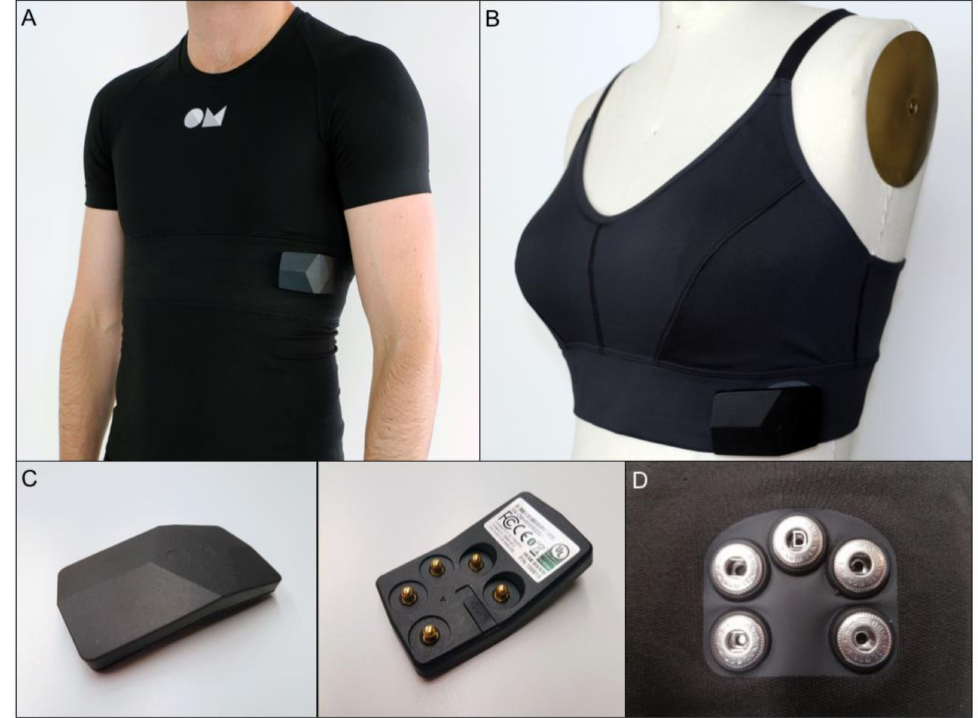
Figure 1. OMgarments are biointeractive wearable ECG sensors. The OMsignal garments represent a novel type of wearable ECG sensors and consist of two different products: The OMshirt (men) ( A ) and the OMbra (women) ( B ). Both garments are intended to be worn as underwear and contain integrated, silicone-based sensors that are in contact with the skin recording a single-lead ECG corresponding to a modified V5-lead. The ECG sensors are connected to the acquisition module ( C ) through five snaps ( D ). The acquisition module has the capacity to save or process ECG signals for real-time or offline